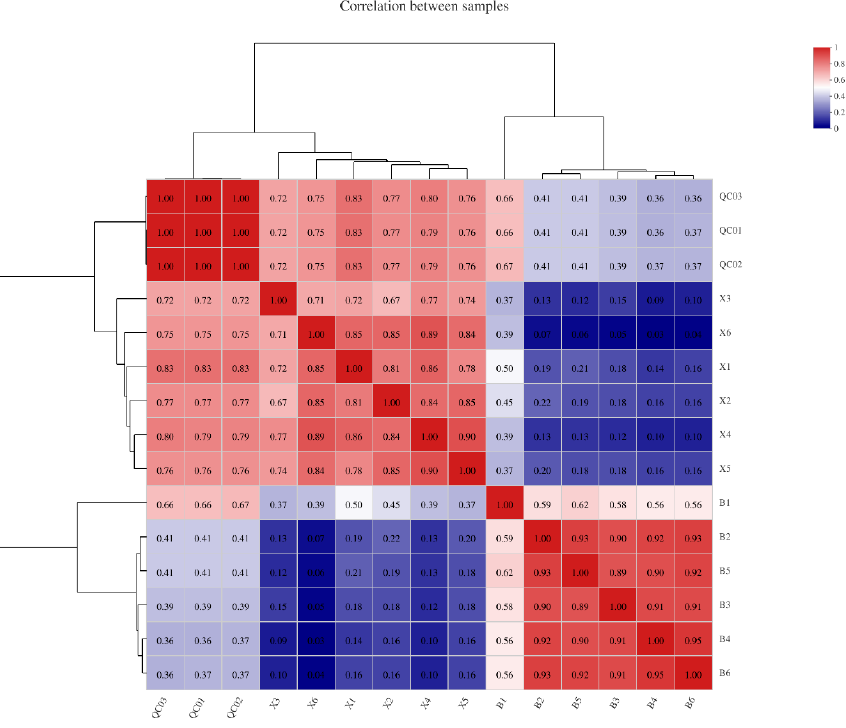
Figure 4. Correlation between samples. Each grid in the figure represents the correlation between two samples; different colors represent the relative size of correlation coefficients between samples; the length of clustering branches represents the relative distance between samples.